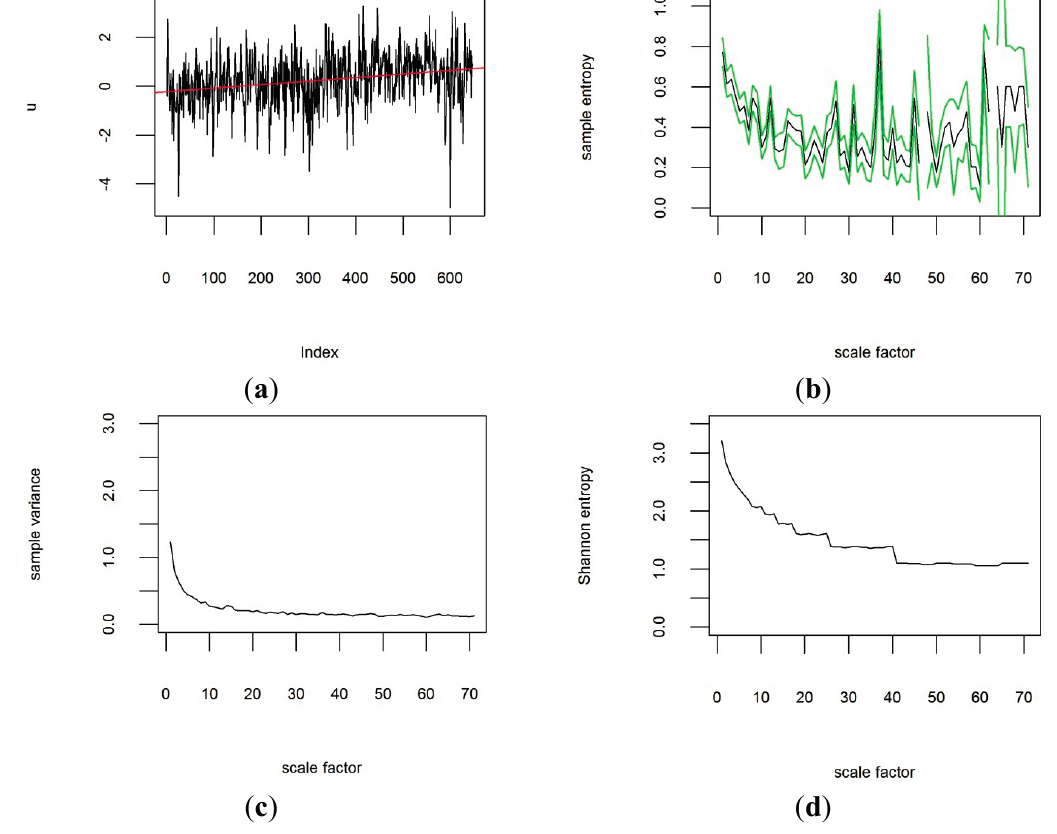
Figure 4. Time-series from 1961–2014 of CRUTEM4v variance-adjusted surface temperature anomaly data for grid box [8|35] centred on 52.5° latitude and − 7.5° longitude, with m = 3 and r = 0.3. Scale factor is shown in months. ( a ) original time-series; ( b ) multi-scale sample entropy for the grid box (95% confidence intervals in green) against scale factor; ( c ) sample variance for different scale factors; ( d ) Shannon information theoretic entropy for different scale factors. For the MSE in (b), missing data points represent scales at which no template matches were found.